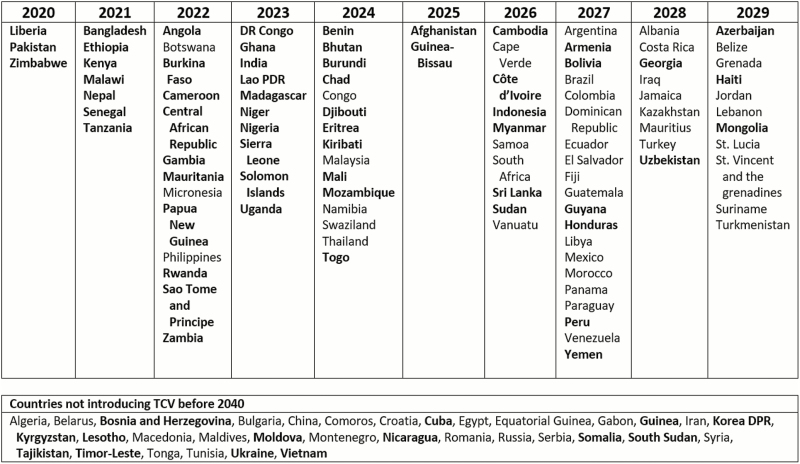
Base case year of introduction. Bold font indicates Gavi eligibility as of 2018. Abbreviation: TCV, typhoid conjugate vaccine.